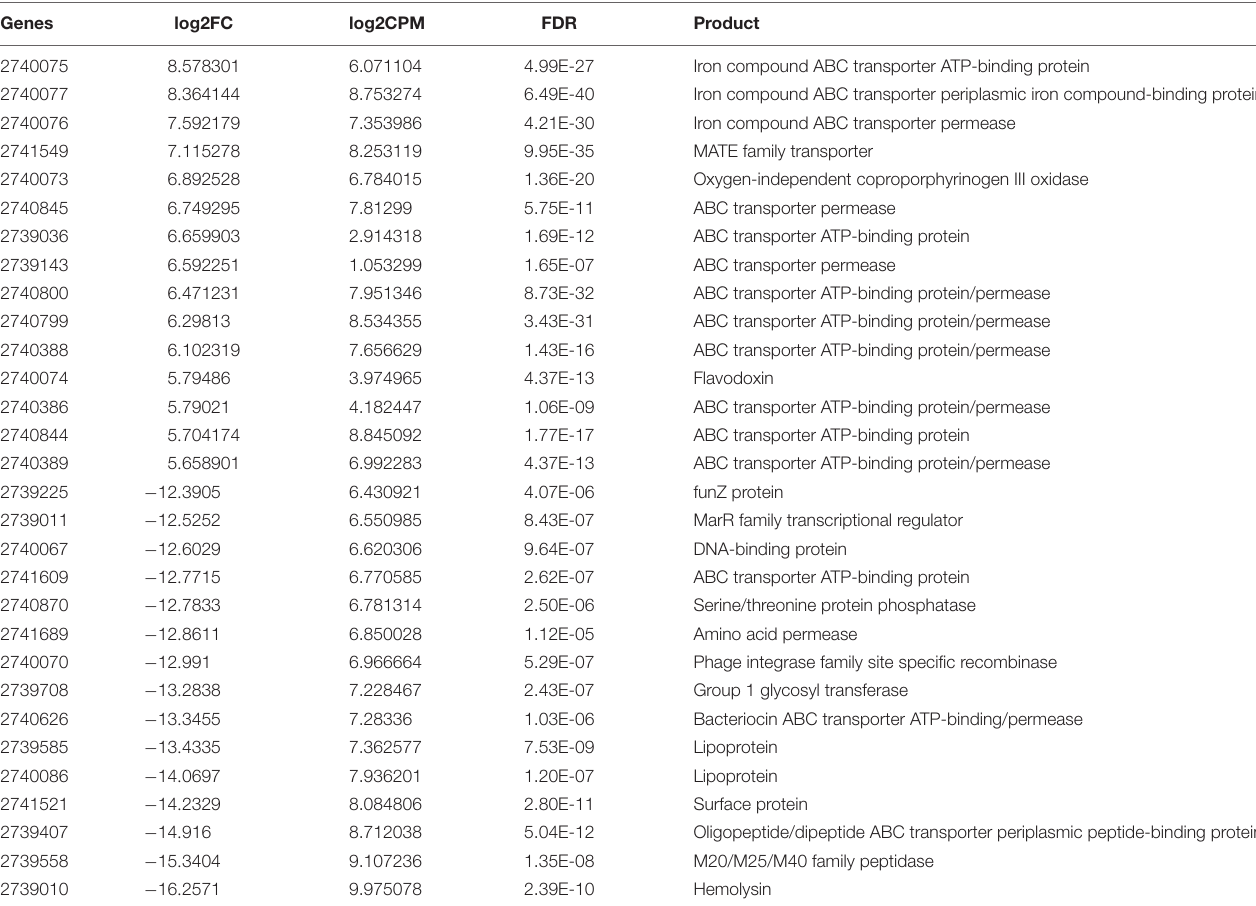
TABLE 3 | Differentially expressed genes (15 most up- and down-regulated in periodontal pocket) between periodontitis and laboratory culture in Treponema denticola. Genes log2FC log2CPM FDR